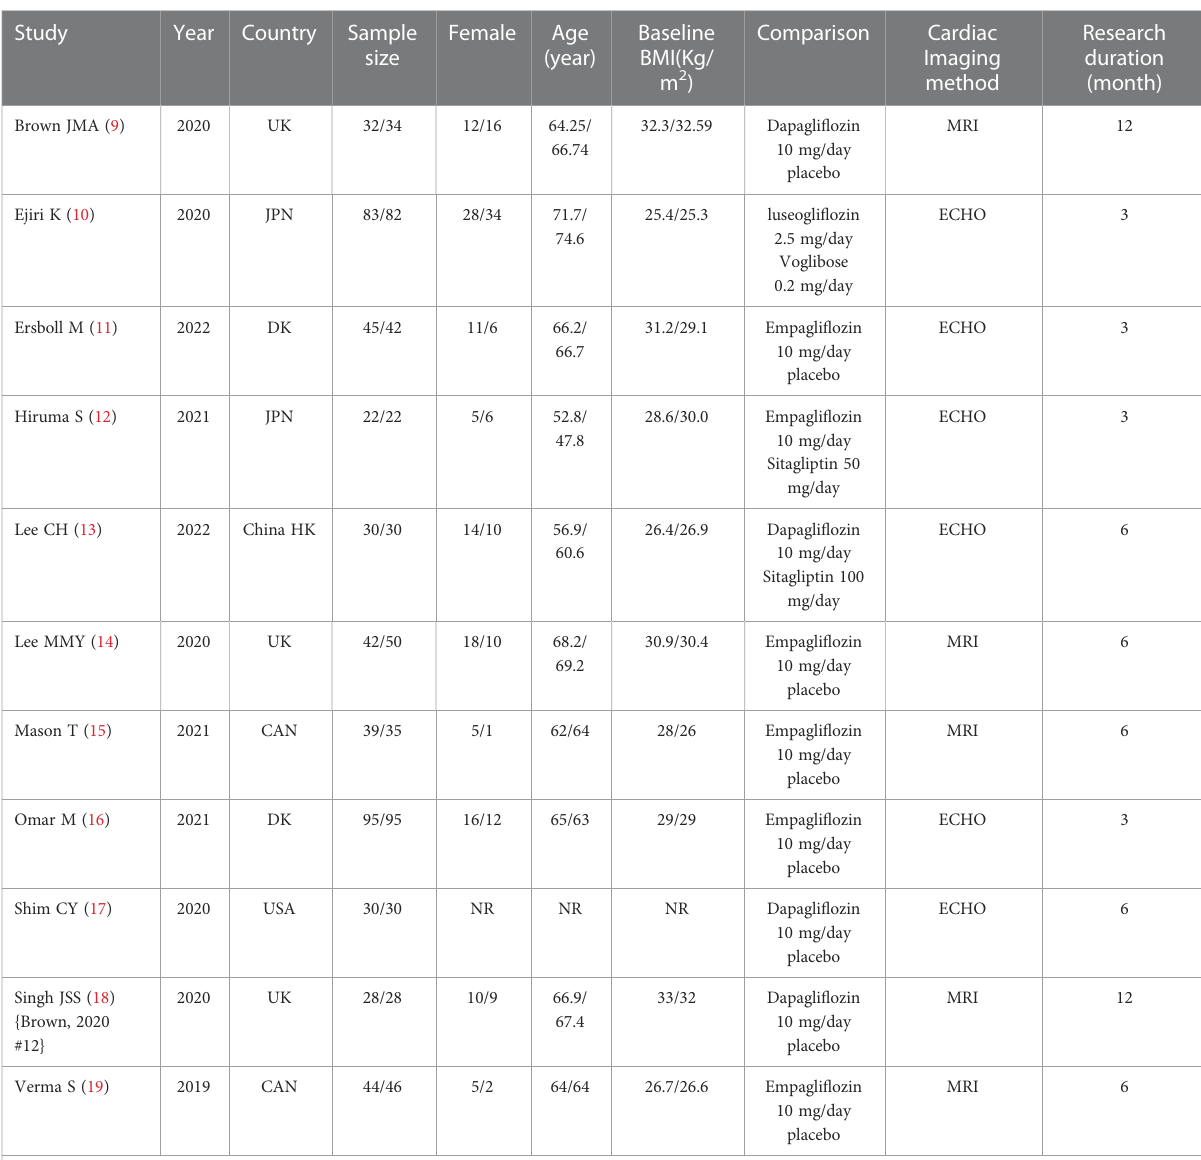
TABLE 1 Characteristics of the 11 included